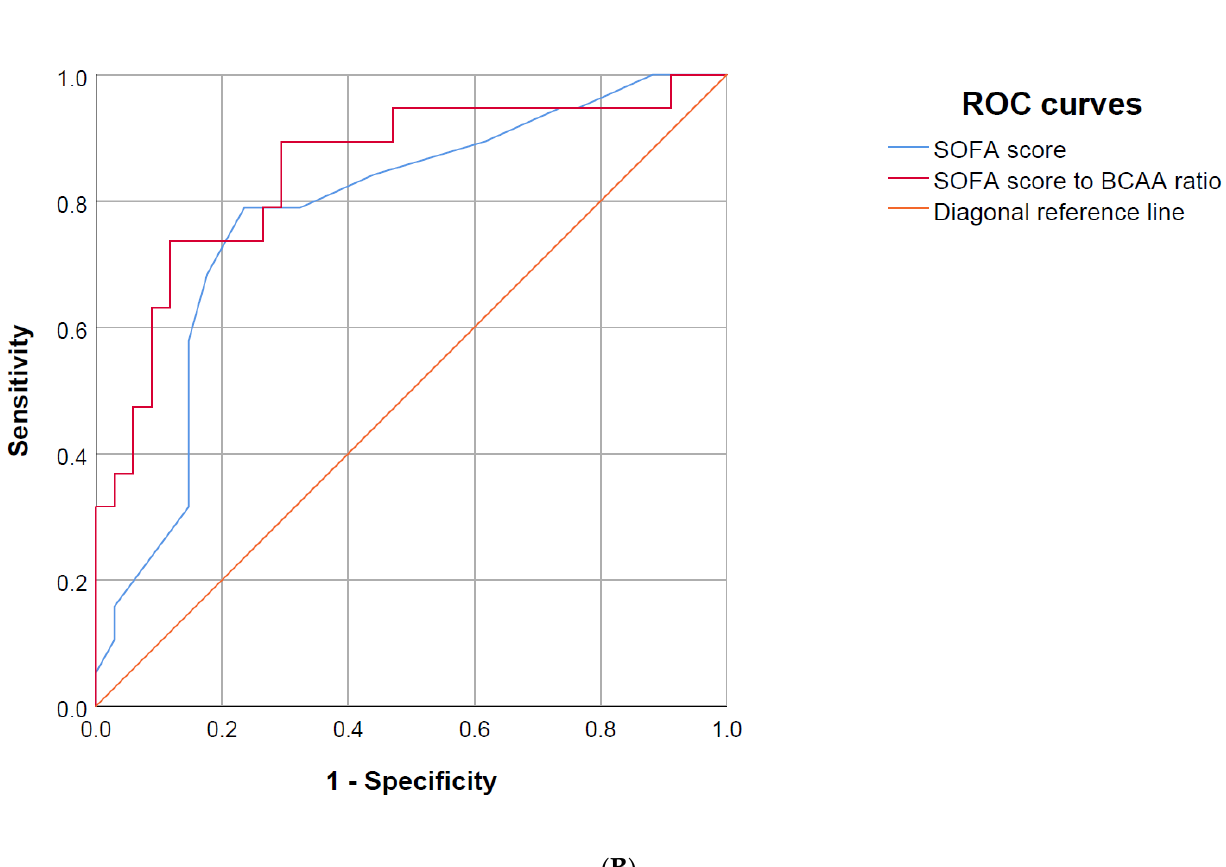
Figure 4. Area under the receiver operating characteristics (AUROC) of branched-chain amino acids for ICU-mortality. ( A ): AUROC for valine (blue line, 0.75 [0.62–0.89]), leucine (red line, 0.73 (0.59–0.88)) and isoleucine (green line, 0.71 (0.57–0.85)). ( B ): AUROC for the sequential organ failure assessment (SOFA) score (blue line, 0.78 (0.65–0.91)) and the SOFA-score to branched-chain amino acid ratio (red line, 0.85 (0.73–0.96)). The orange line is the diagonal reference line (50% chance).